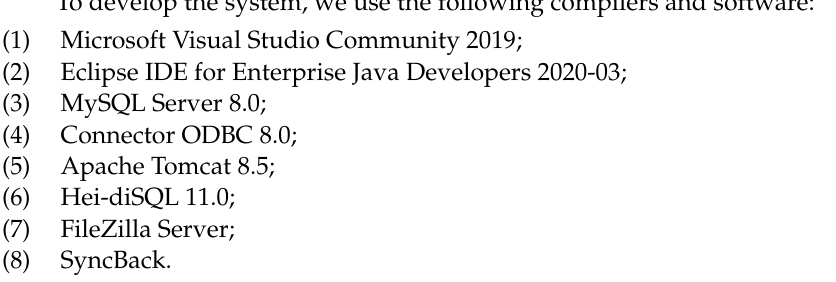
Figure 14. Advantech sensor switches [19]. Figure 15. Sensor detection function.